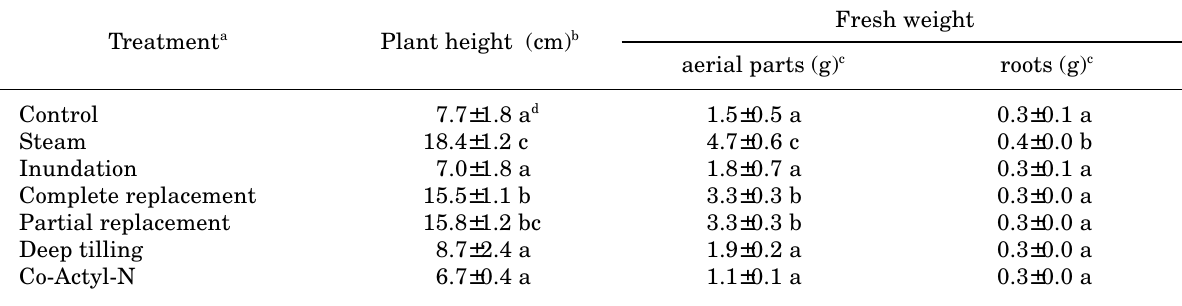
Table 1. Effect of various soil treatments on “stanchezza” (soil sickness) of sweet basil. Results are expressed as plant height and f. wt. of the roots and aerial plant organs 60 days after sowing on October 30, 1995 (Trial